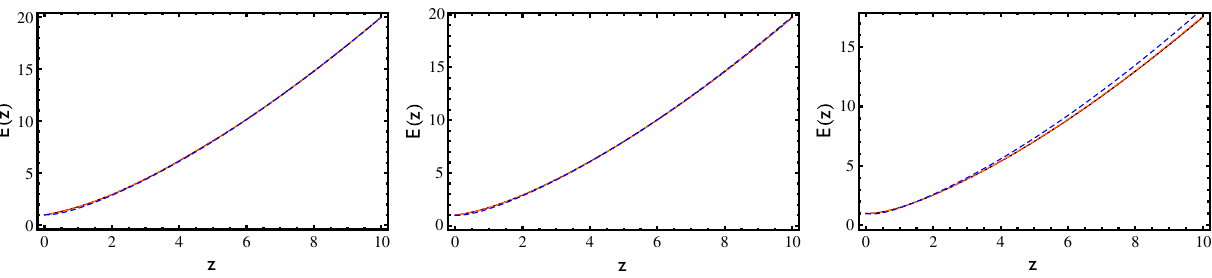
Fig. 2 The effects of the perfect EoS of DE ω on the dimensionless the cases of η = 0 . 003 , 0 . 03 , 0 . 3 and the solid (red), dotted (black), Hubble parameter E ( z ) for different values of bulk viscosity coefficient dash-dotted (orange) and dashed (blue) lines correspond to the case of η in the V ω DE model. From left to right, fixing (cid:11) = 0 . 3, we consider ω = 0, − 1.005, − 1.05 and − 1.5, respectively m